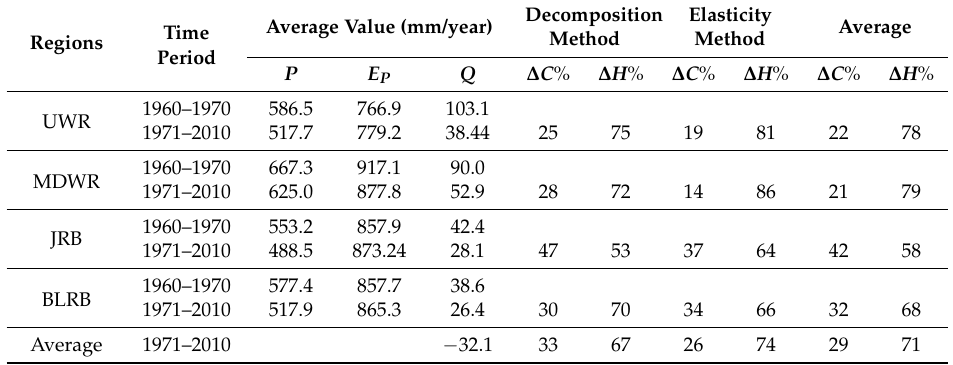
Table 3. Table 3 The contribution of climate and human impacts to streamflow changes during 1971–2010 with 4 sub-catchments considered in this study.